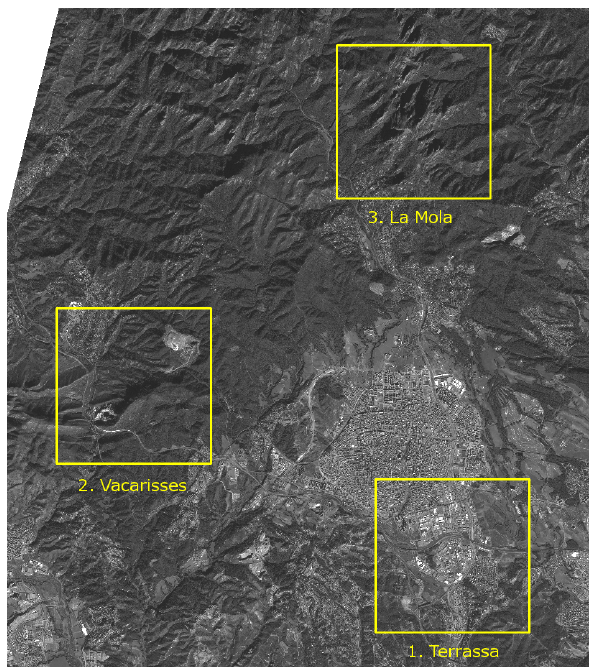
Figure 1: Cartosat-1 image showing the three test areas.